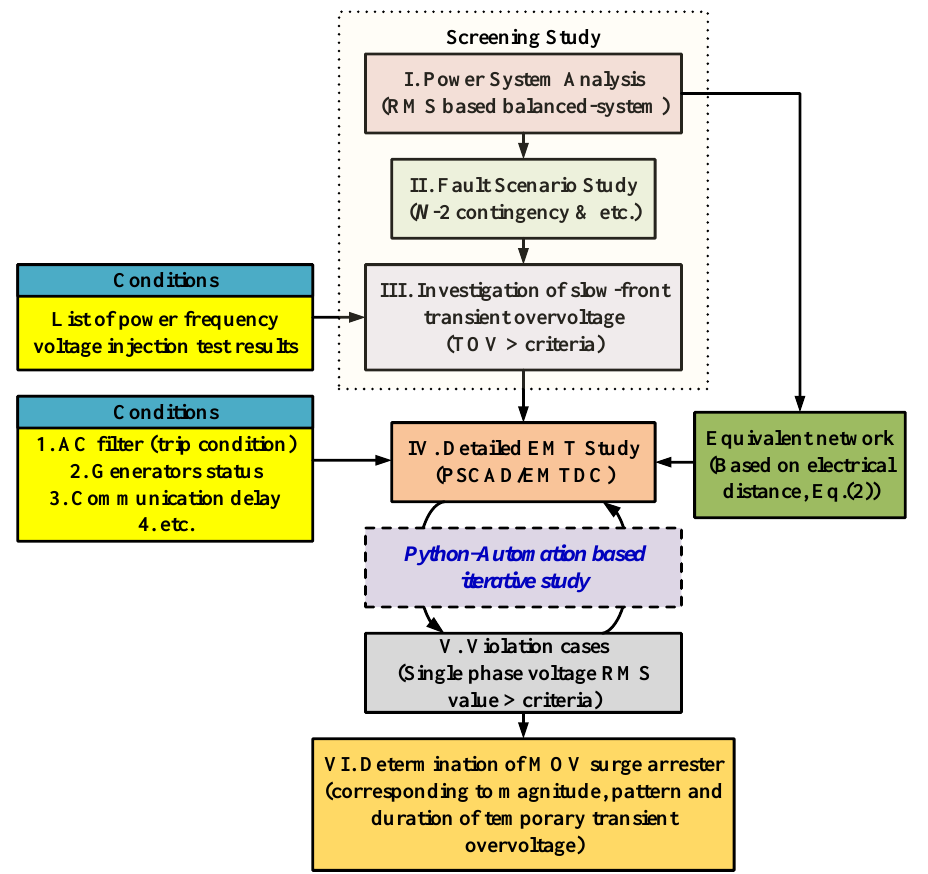
Figure 3. Procedure of MOV surge arrester selection for LCC-HVDC transmission